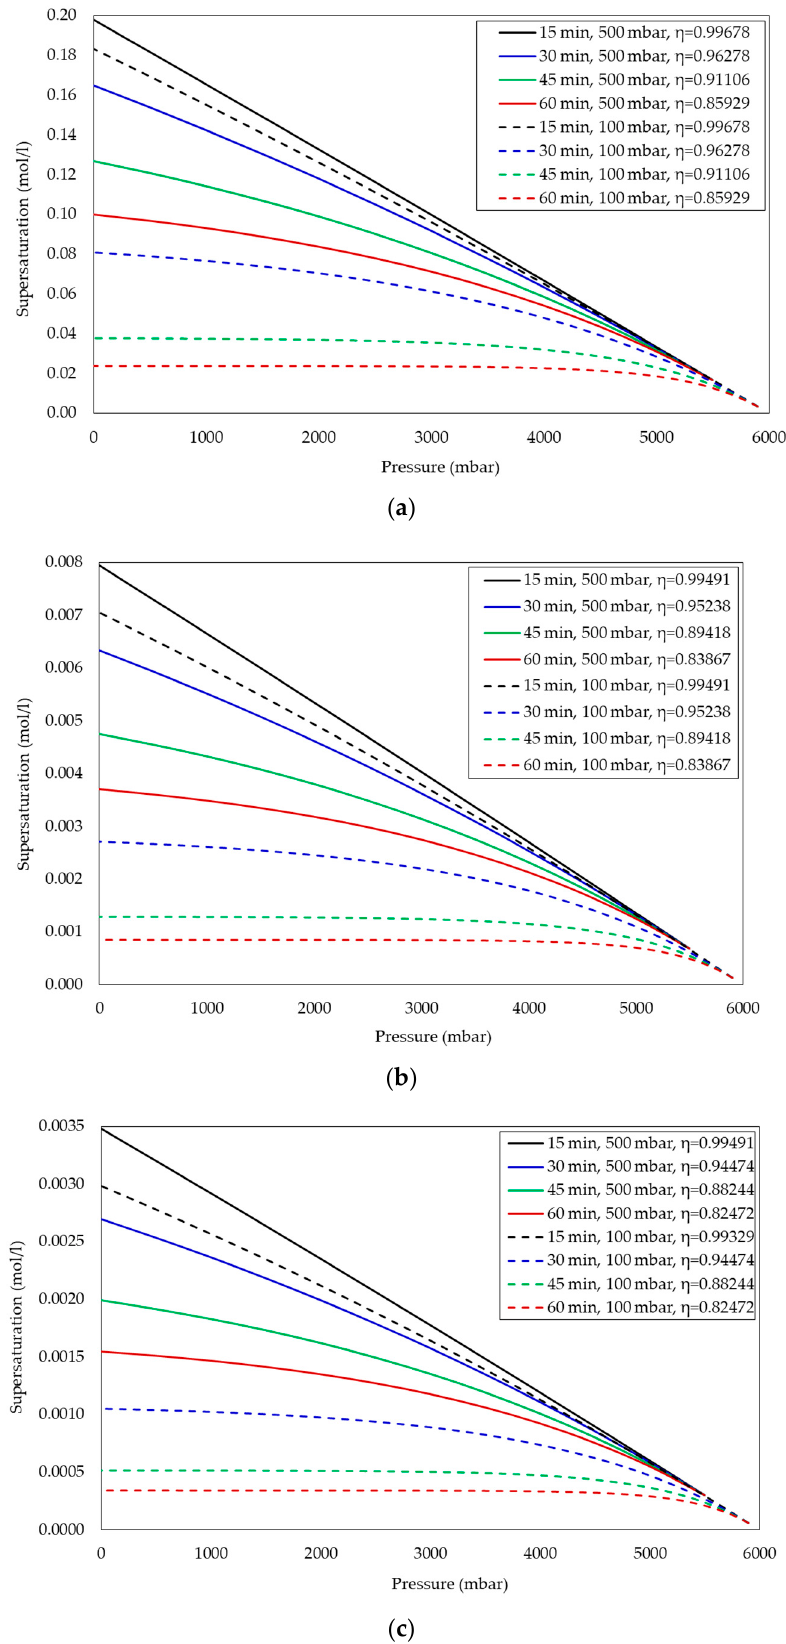
Figure 2. Effect of waiting time on supersaturation in the ( a ) CO 2 -water system; ( b ) CH 4 -water system; ( c ) N 2 -water system.